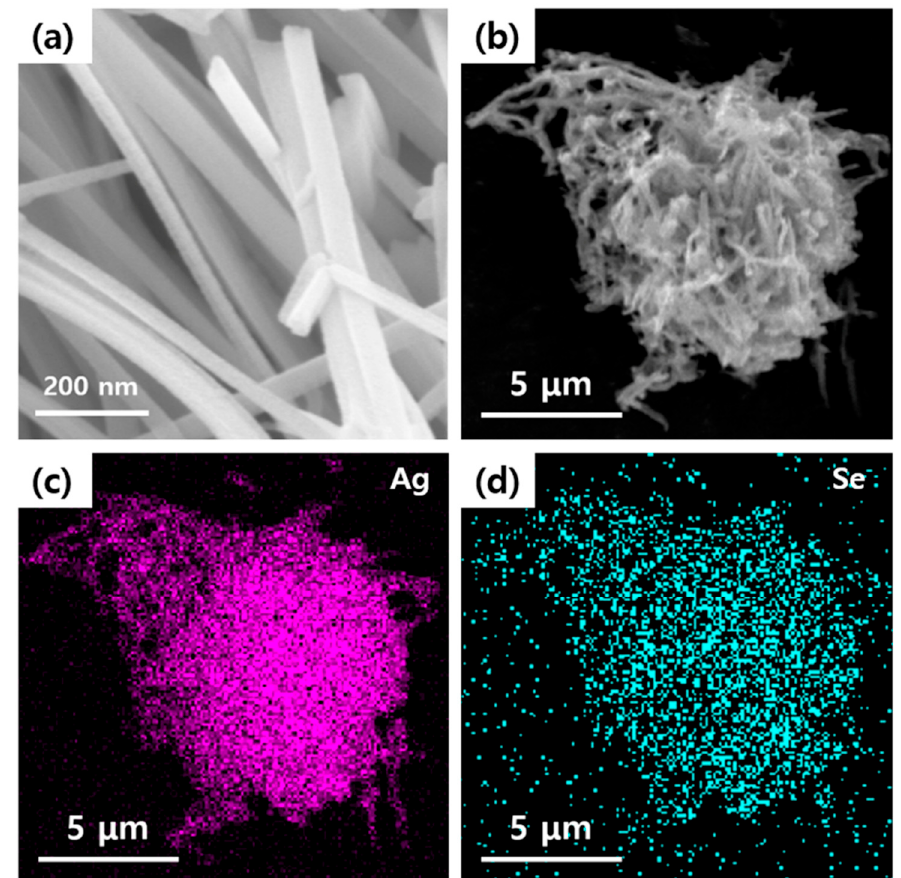
Figure 1. ( a , b ) FE-SEM images and the corresponding EDS elemental mapping of ( c ) Ag and ( d ) Se atoms.